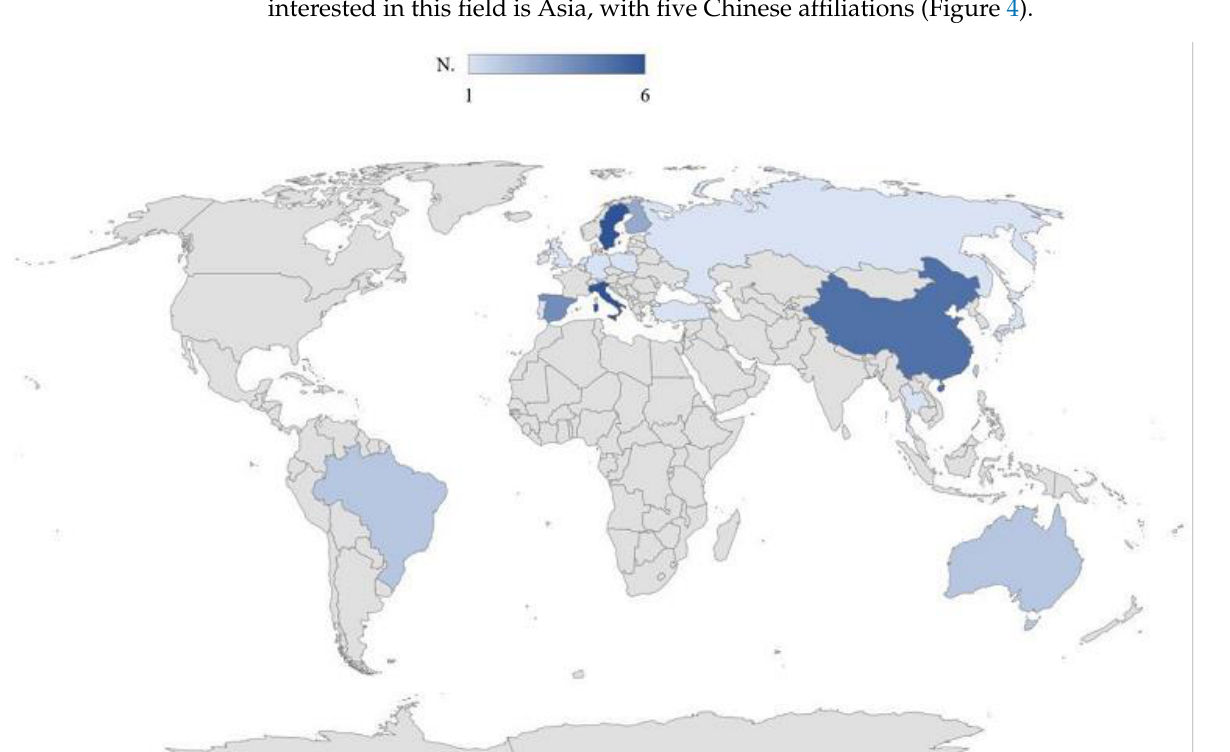
Figure 3. Publishing journals. Source: personal elaboration by the authors.